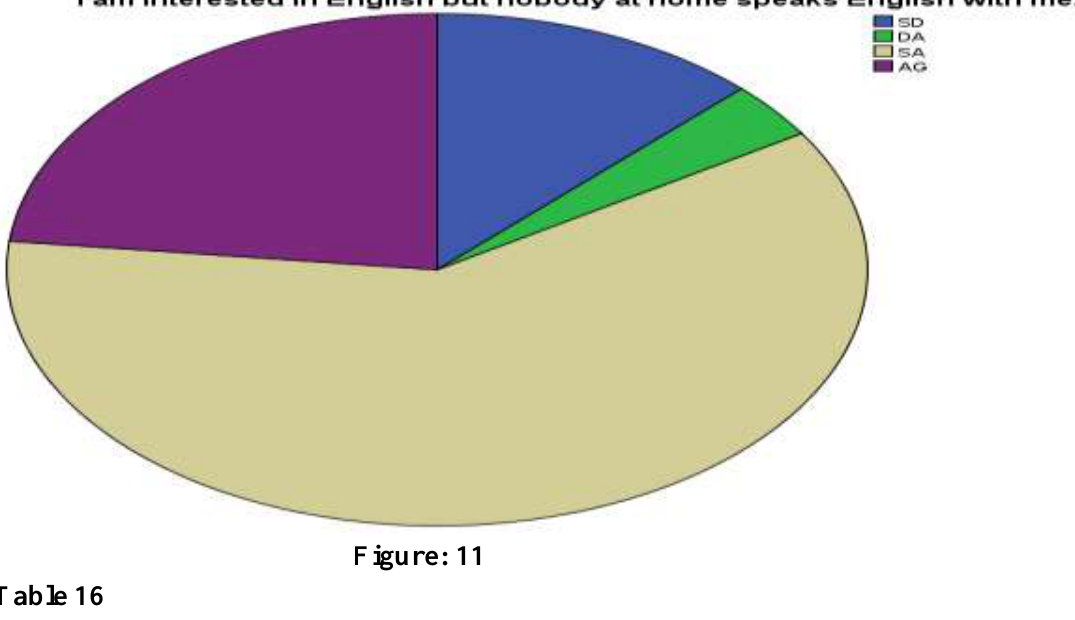
AV AIDS and motivational bibliographies when used in classroom inspires me a